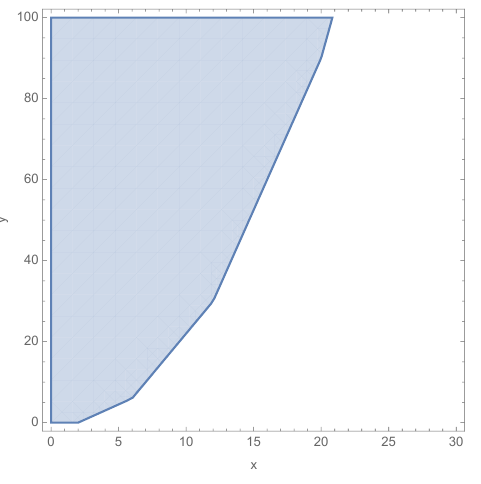
Figure 7 . The constraints curved out from h a 5 , i, i +1 , ∞i > 0